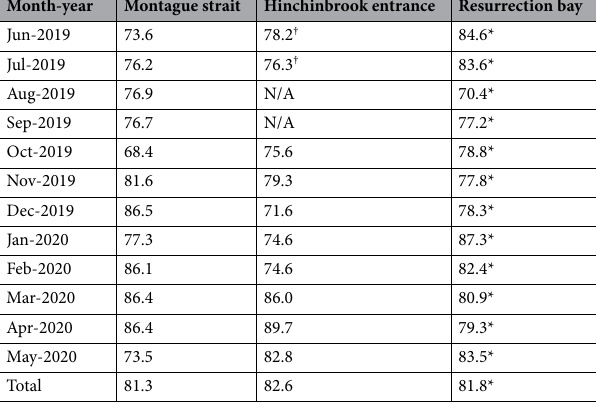
Table 1. Percentage of recordings with killer whale detections at hydrophone locations in the northern Gulf of Alaska in which vocalizations were present in the first half of the recording. Months that are not otherwise denoted recorded on a 5 min on, 10 min off duty cycle. *4 min on, 16 min off duty cycle. † 4 min on, 11 min off duty